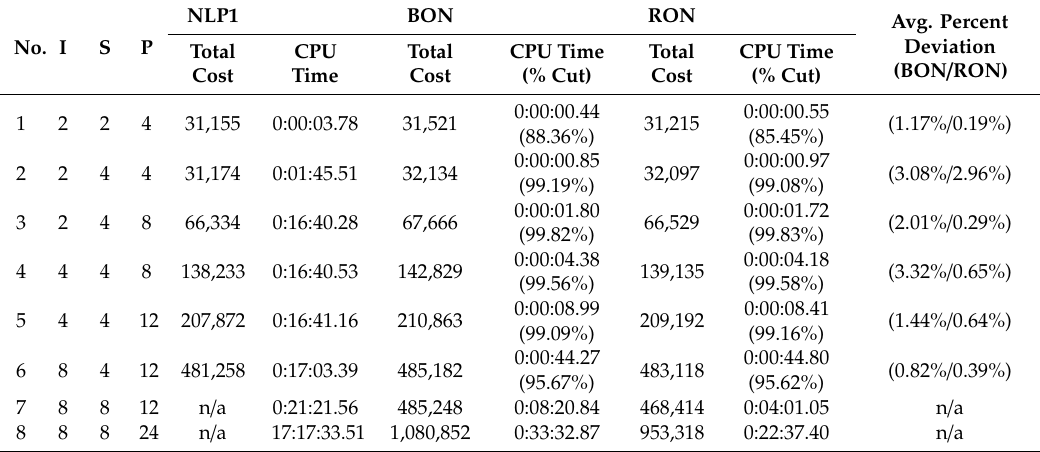
Table 7. Comparison between NLP1, BON, and RON for a variety of problem